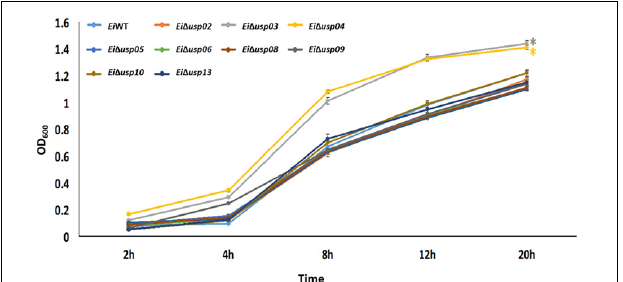
FIGURE 3 | Growth of E. ictaluri USP mutants and WT in BHI broth. The data represent means of four replicates. Ei (cid:49) usp03 and Ei (cid:49) usp04 have a significantly ( p < 0.001) higher growth rate than Ei WT and other USP mutants, which indicated by a “ ∗ .” No significant differences were observed in the growth kinetics of Ei WT and Ei (cid:49) usp02 , Ei (cid:49) usp05 , Ei (cid:49) usp0 6, Ei (cid:49) usp07 , E i (cid:49) usp08 , Ei (cid:49) usp09 , Ei (cid:49) usp10 , and Ei (cid:49) usp13 strains.